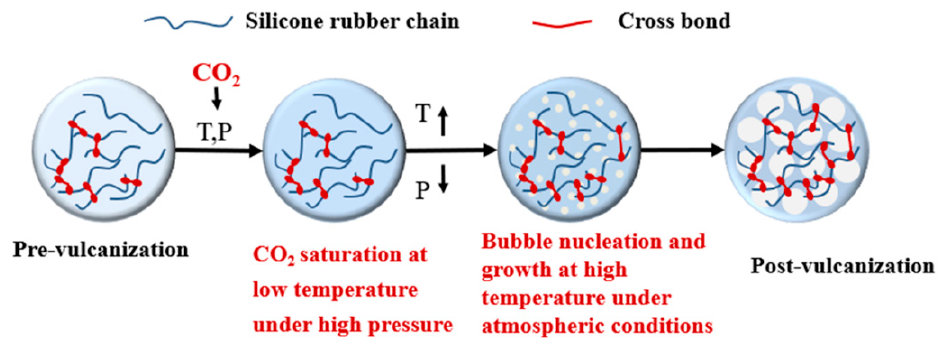
Figure 2. Schematic diagram of foaming silicone rubber process.